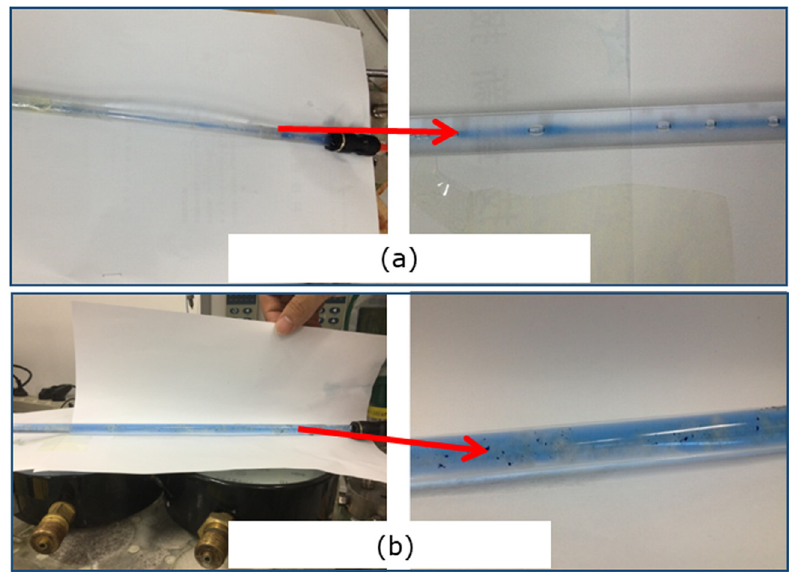
Figure 13: Reverse water fl ooding in transparent pipe in the case of di ff erent gel injection ways. ( a ) In situ crosslinked gel, ( b ) pre - crosslinked